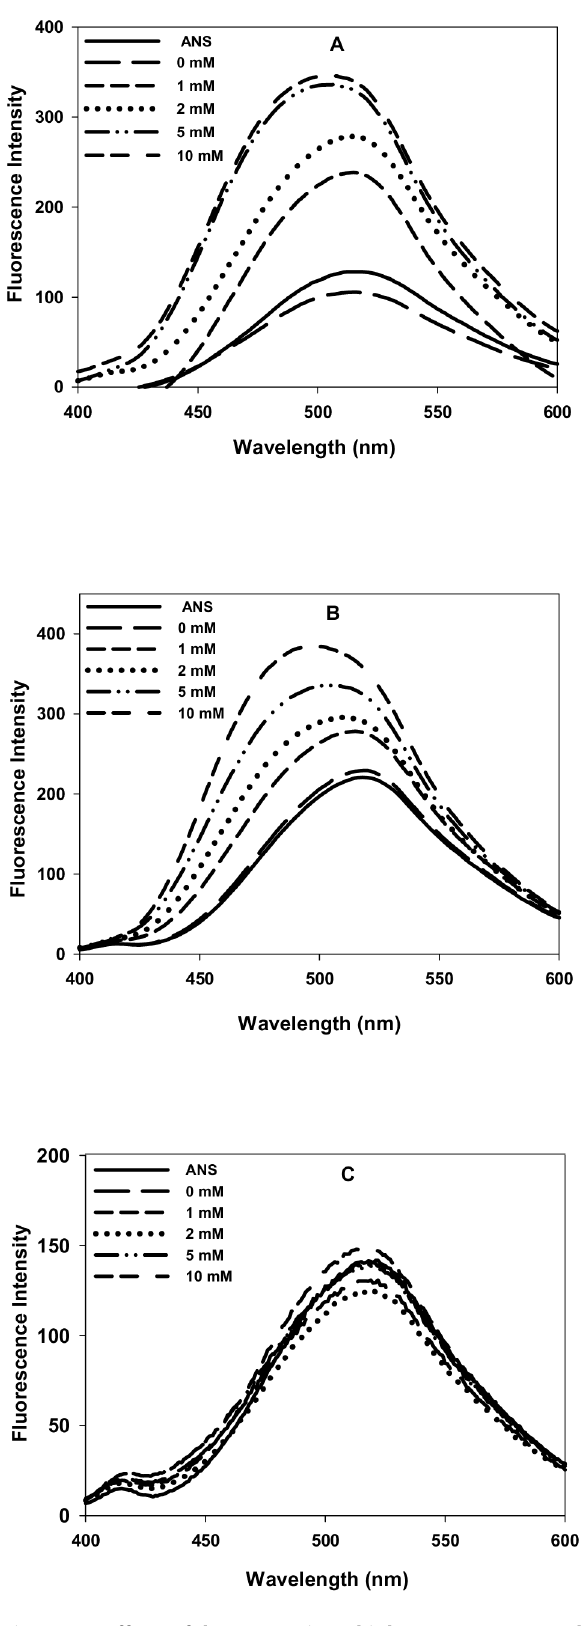
Figure 5. Effect of homocysteine thiolactone (HTL) on the extrinsic fluorescence of the native state of proteins. ANS binding study (A) cyt-c (at 18 hours), (B) a -LA (at 4 hours) and (C)